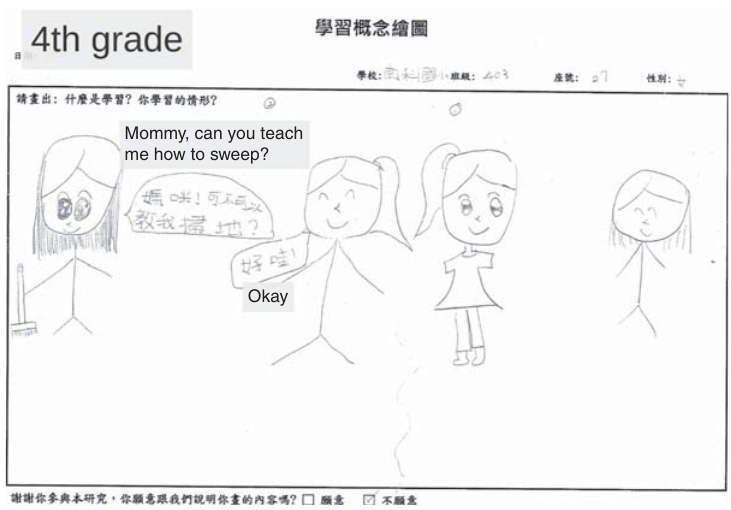
Figure 12. A drawing by a